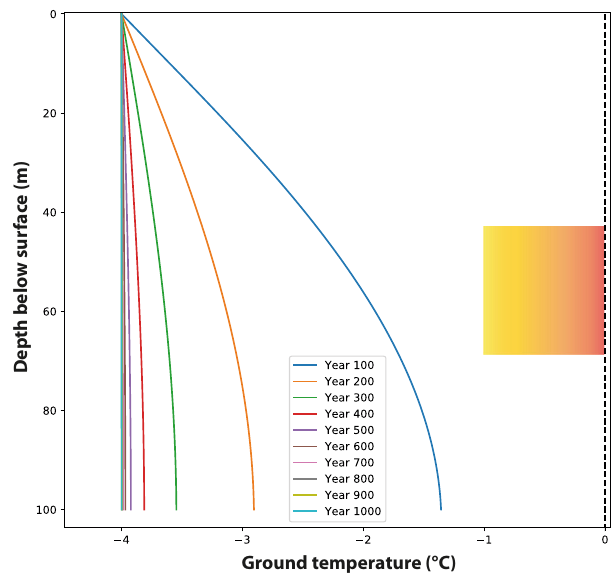
Fig. 2 Scenario 1 simulating the development and deepening of permafrost during a cold and dry stadial. This model uses a mean annual air temperature of − 4 °C and an initial temperature at the top of the ground of 1 °C. The curves depict the mean annual temperature. The rectangle with the orange shading marks the − 1 to 0 °C window of possible cryogenic cave carbonates formation for the depth range of the Obir caves.